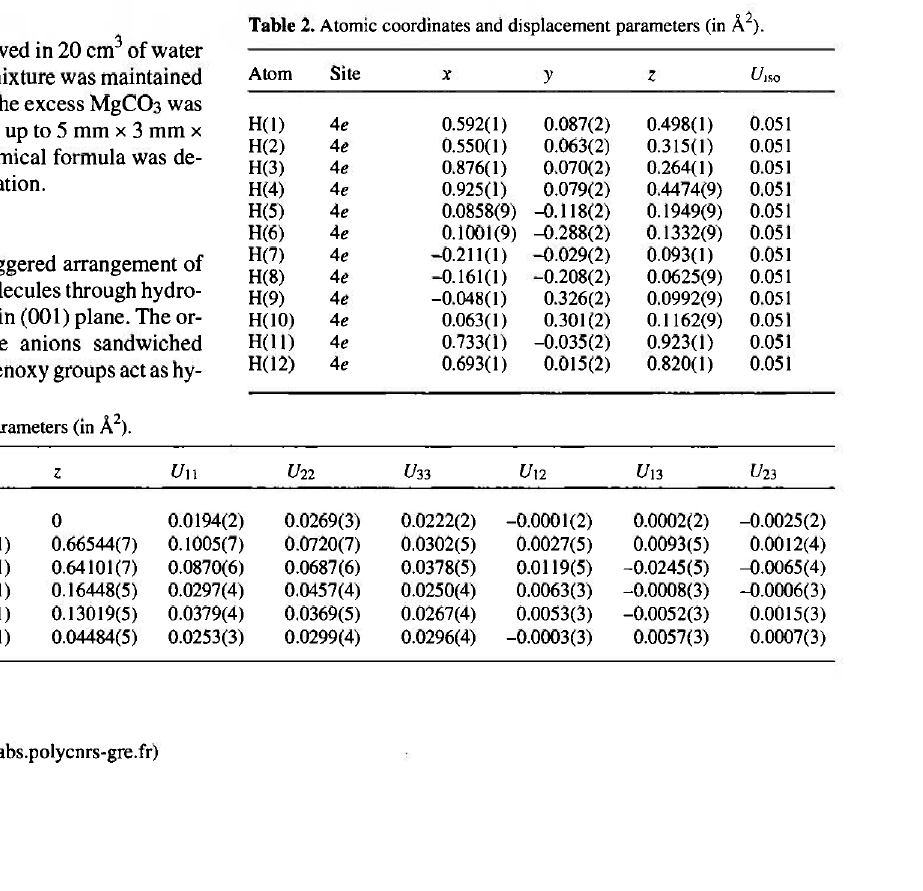
Table 2. Atomic coordinates and displacement parameters (in Ä 2